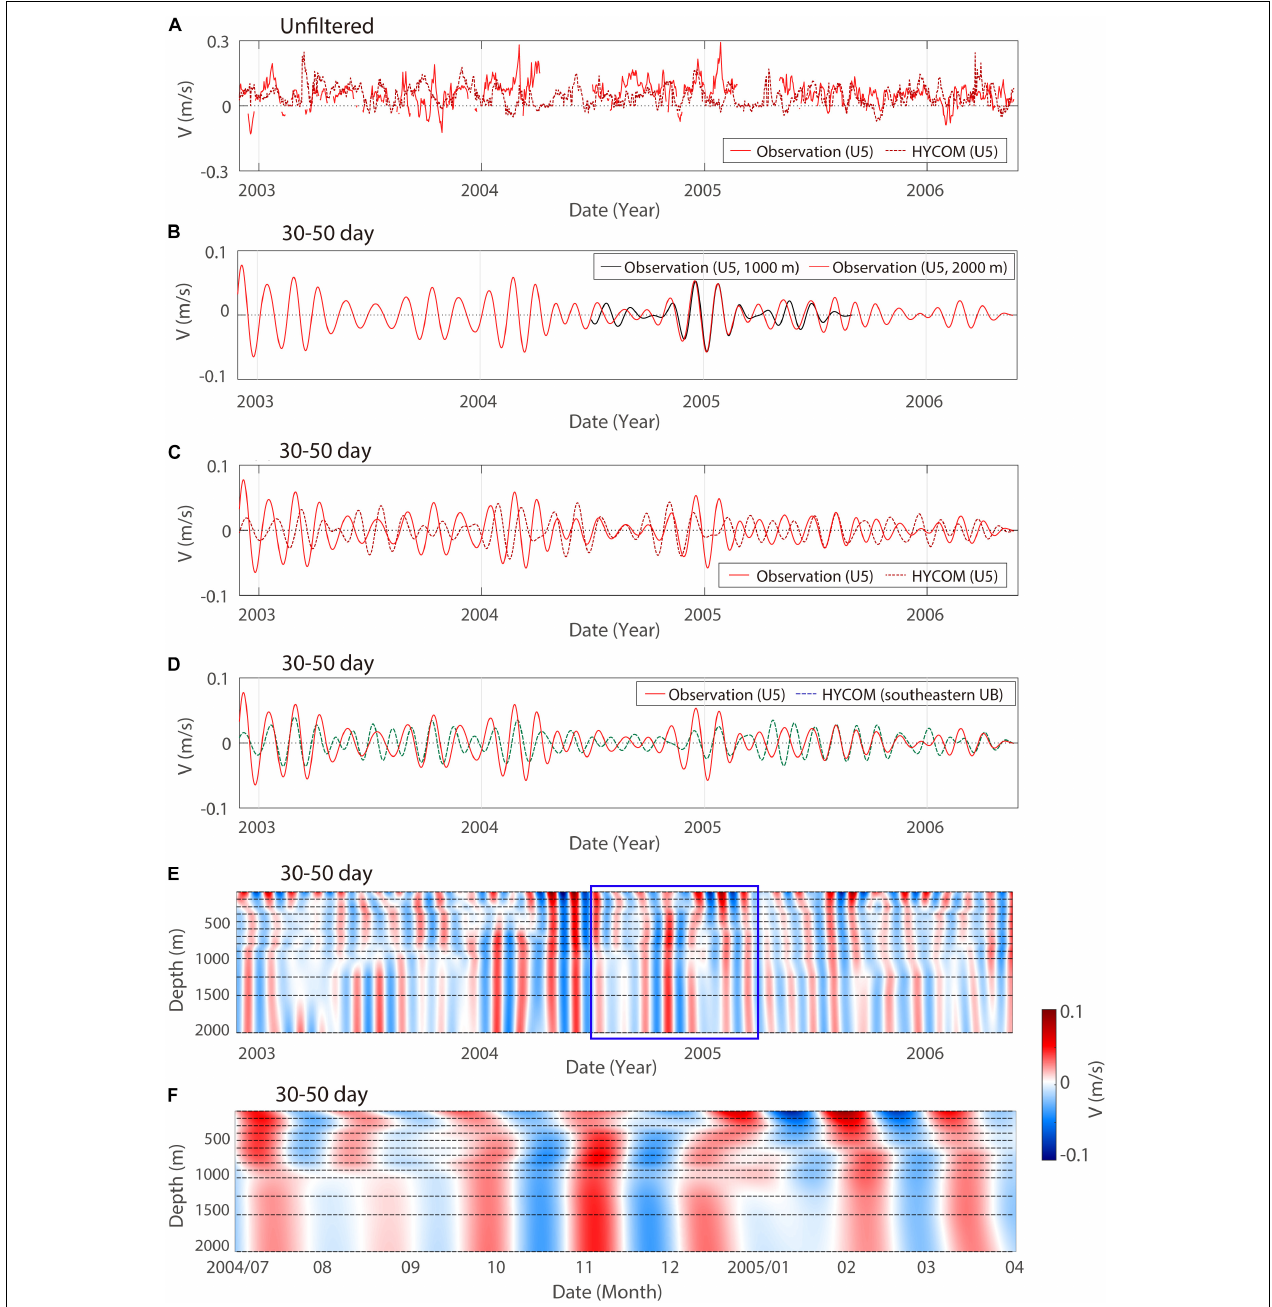
FIGURE 6 | Time series of modeled (dashed) and observed (solid) v currents at 2000 m of the locations of (A,C) U5 and (D) southeastern UB (green squares in Figure 5 ) for the (A) unfiltered and (C,D) longer intraseasonal band. Those of v currents observed at 1000 m (black) and 2000 m (red) of the location of U5 are compared in panel (B) . Time-depth contours of modeled v currents are shown for longer intraseasonal band at U5 for (E) total period and (F) period from July 2004 to April 2005. The HYCOM depth levels are denoted by black dotted horizontal lines in panels (E,F) .